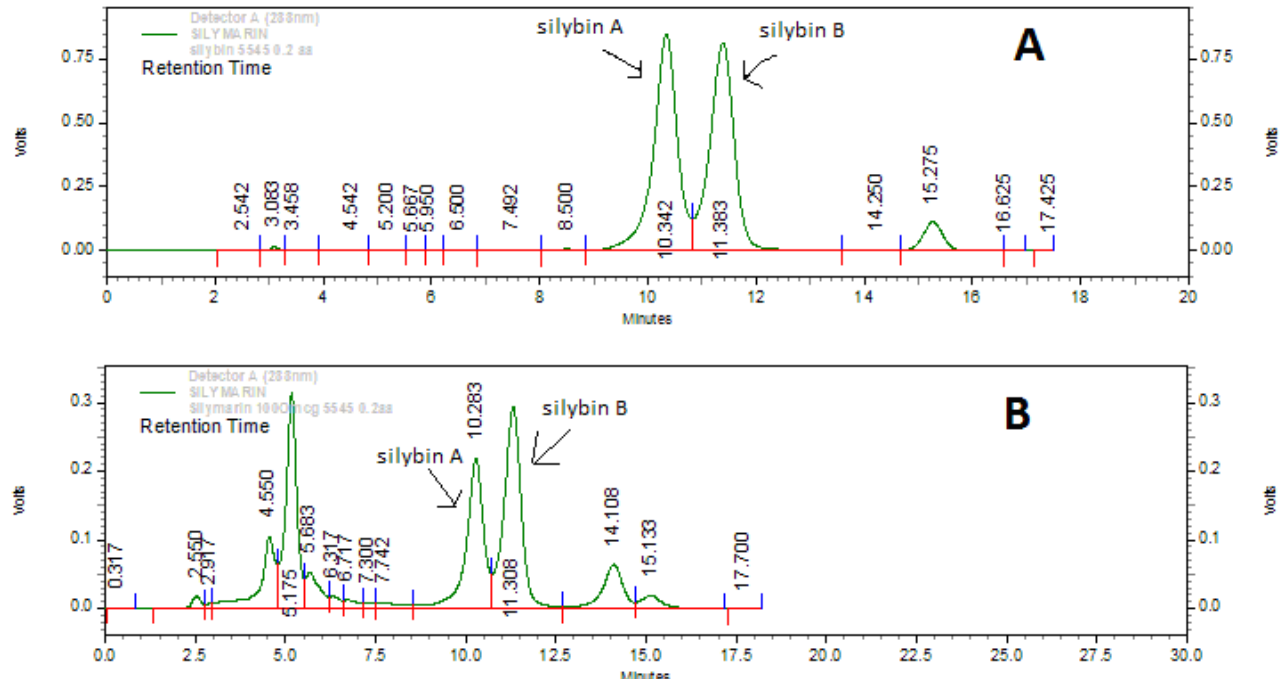
FIGURE 1 - Chromatograms of A) standard silybin and B) whole silymarin extract under optimized chromatographic